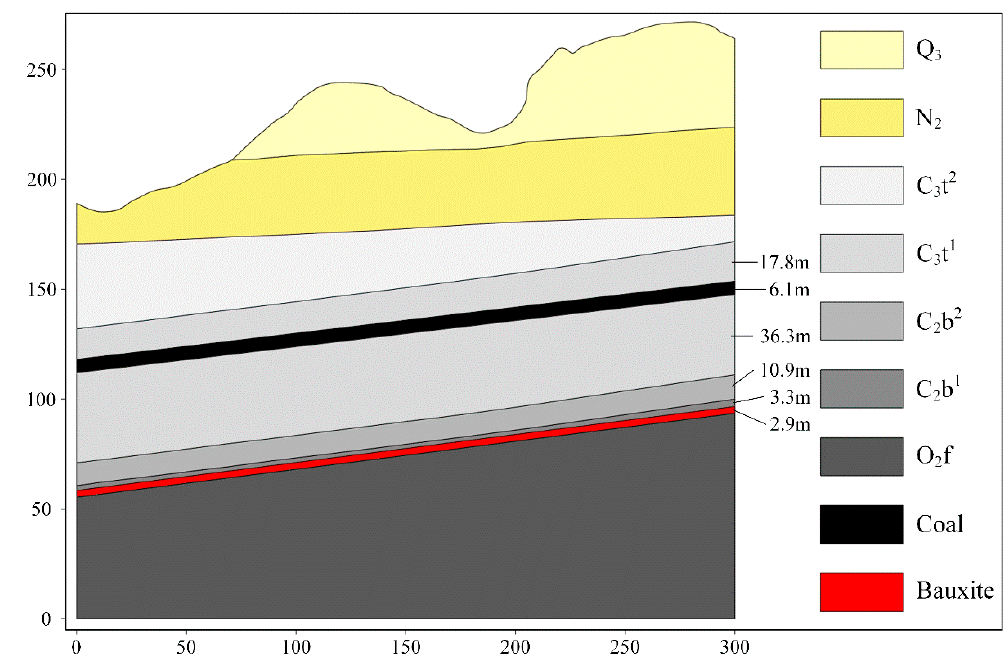
Figure 4. Engineering geological condition of BCS.